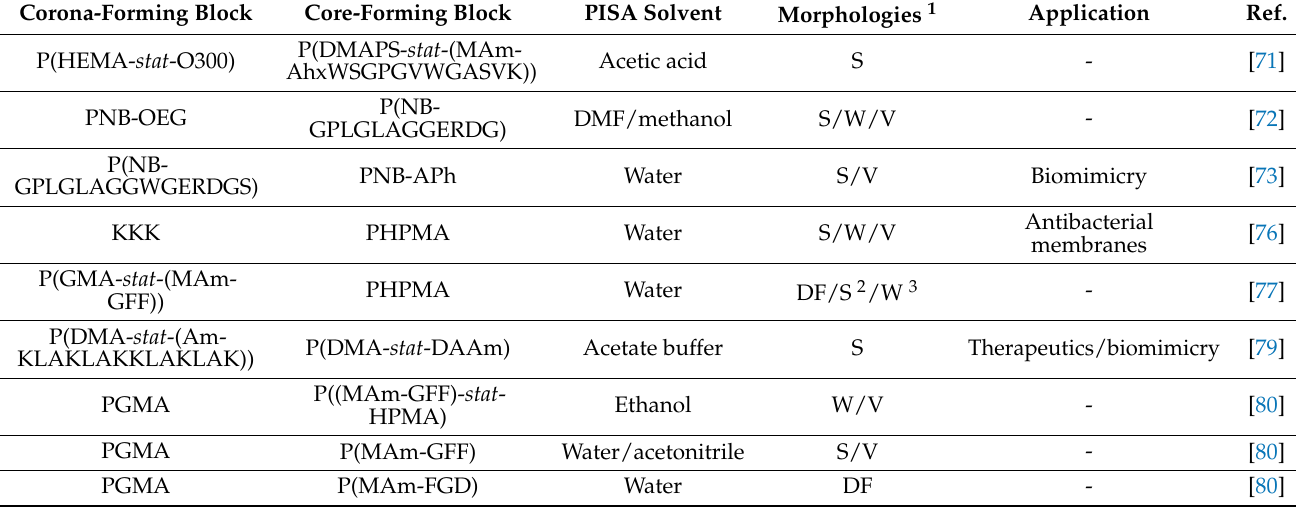
Table 2. Summary of corona- and core-forming blocks, reaction solvents, obtained morphologies, and applications of peptide–polymer hybrid nanostructures prepared via